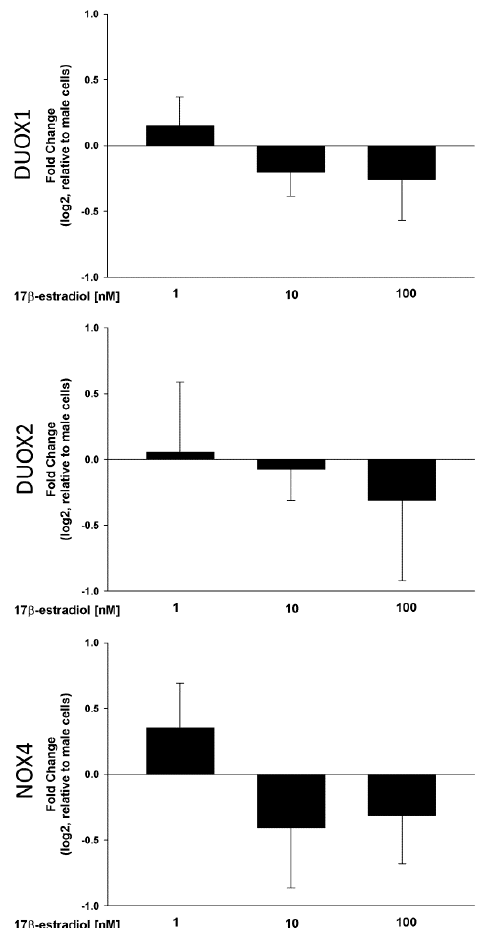
Figure 4. Expression (log2 fold change) of NOX/DUOX oxidases mRNA levels in females. Cells derived from male and female rat thyroid were incubated in the presence of 17 β -estradiol (1.0 nM, 10 nM or 100 nM). mRNA expression was determined by real-time PCR and was expressed relative to the male group. Bars represent the mean ± SE of three independent experiments. No significant differences were found.